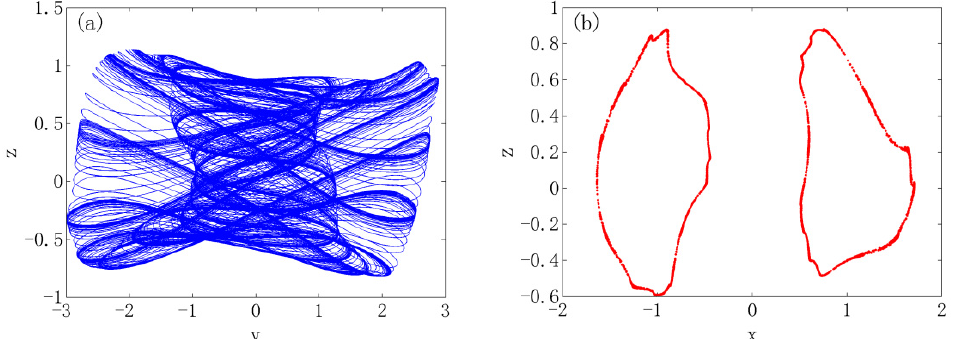
Figure 8. Hidden quasi-periodic attractor of system (4) when β = 0.58. ( a ) Phase trajectory diagram in yz plane; ( b ) Poincare map in xz